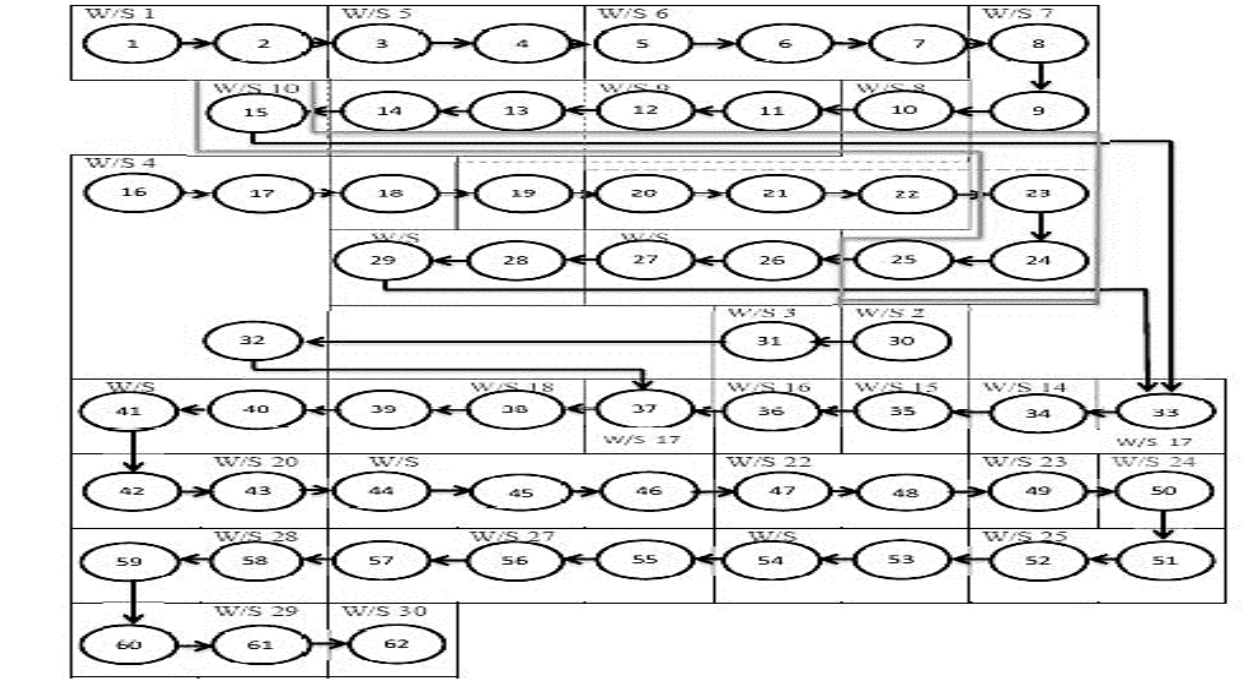
Figure 3. Assignment of work element according to largest candidate